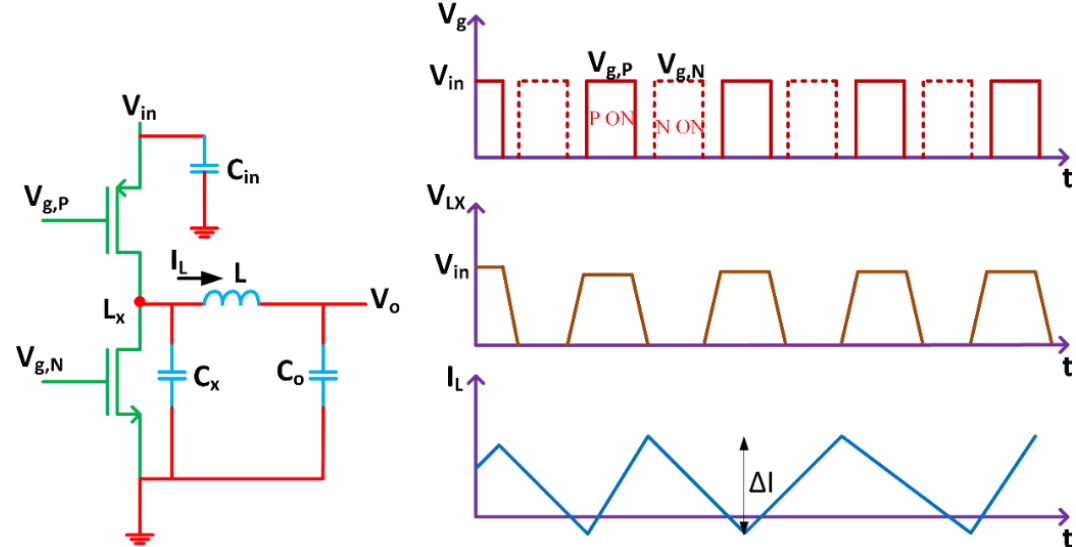
Figure 5. Block diagram of the power stage of the synchronous inductive buck converter with corresponding steady-state waveforms [54]. Reproduced from [54], In Proceedings of the IEEE Power Electronics Specialists Conference: 2008.